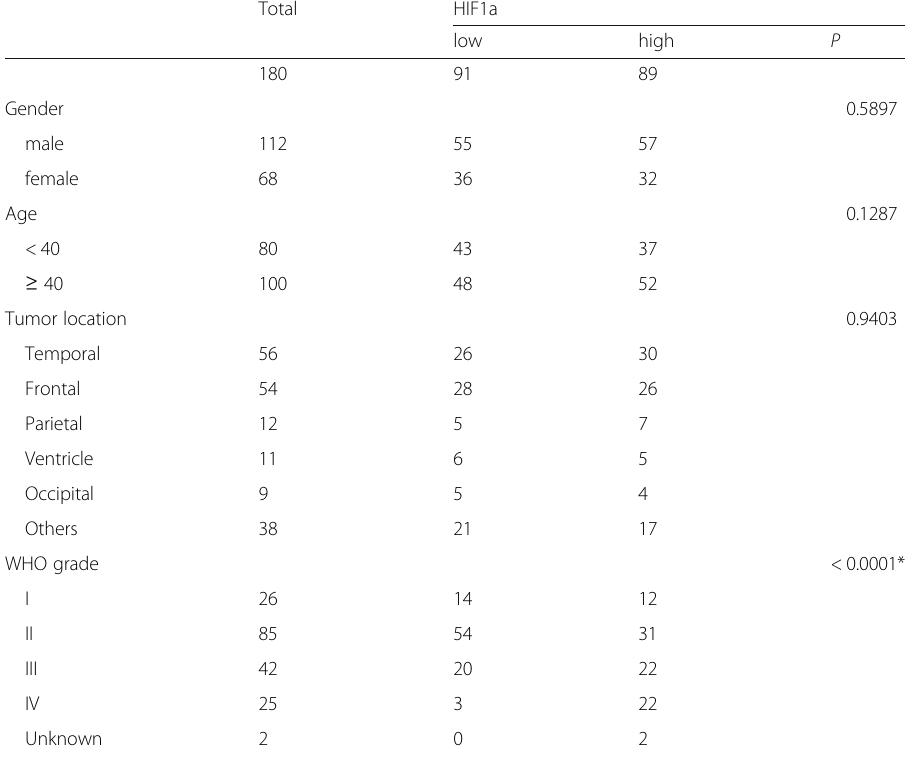
Table 1 Correlation of the expression of HIF1a with clinicopathological features in glioma Total